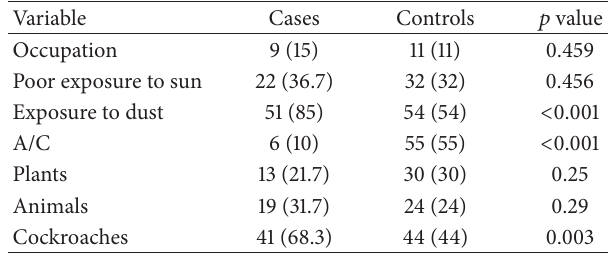
Table 4: Prevalence of risk factors among cases and controls.